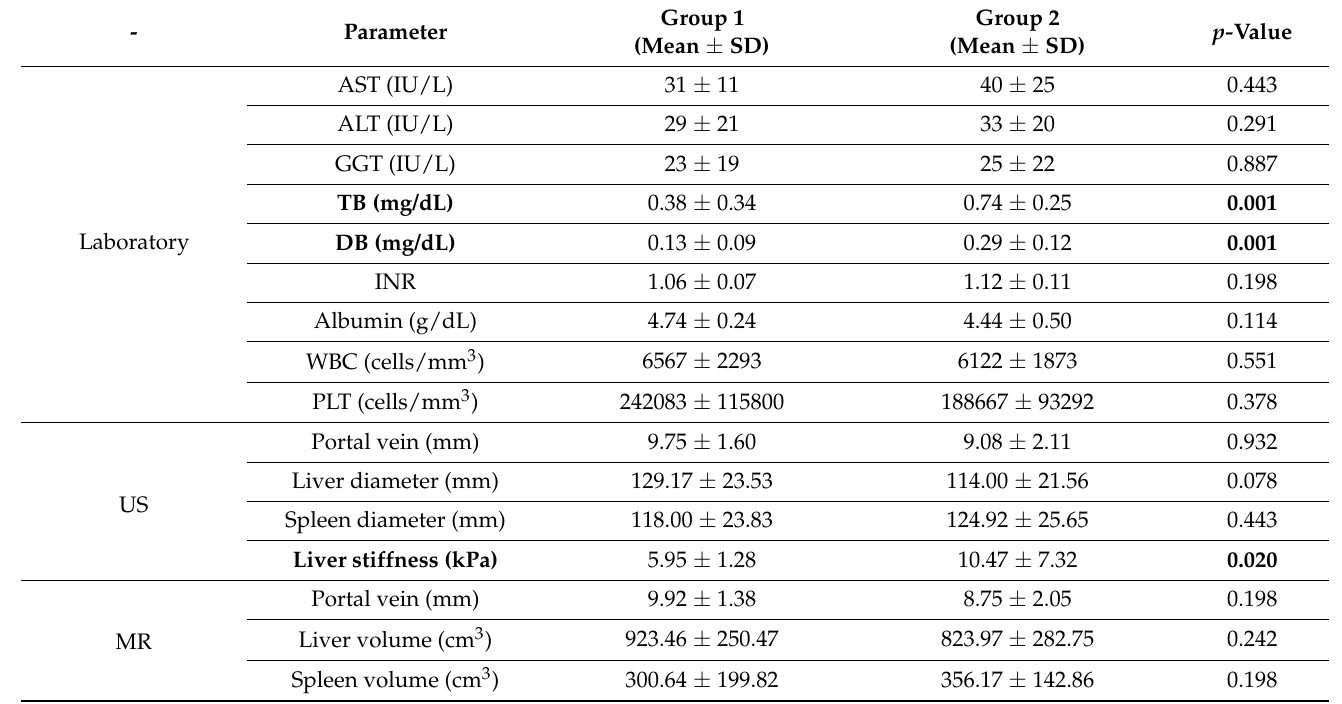
Table 3. Laboratory and imaging results in group 1 and group